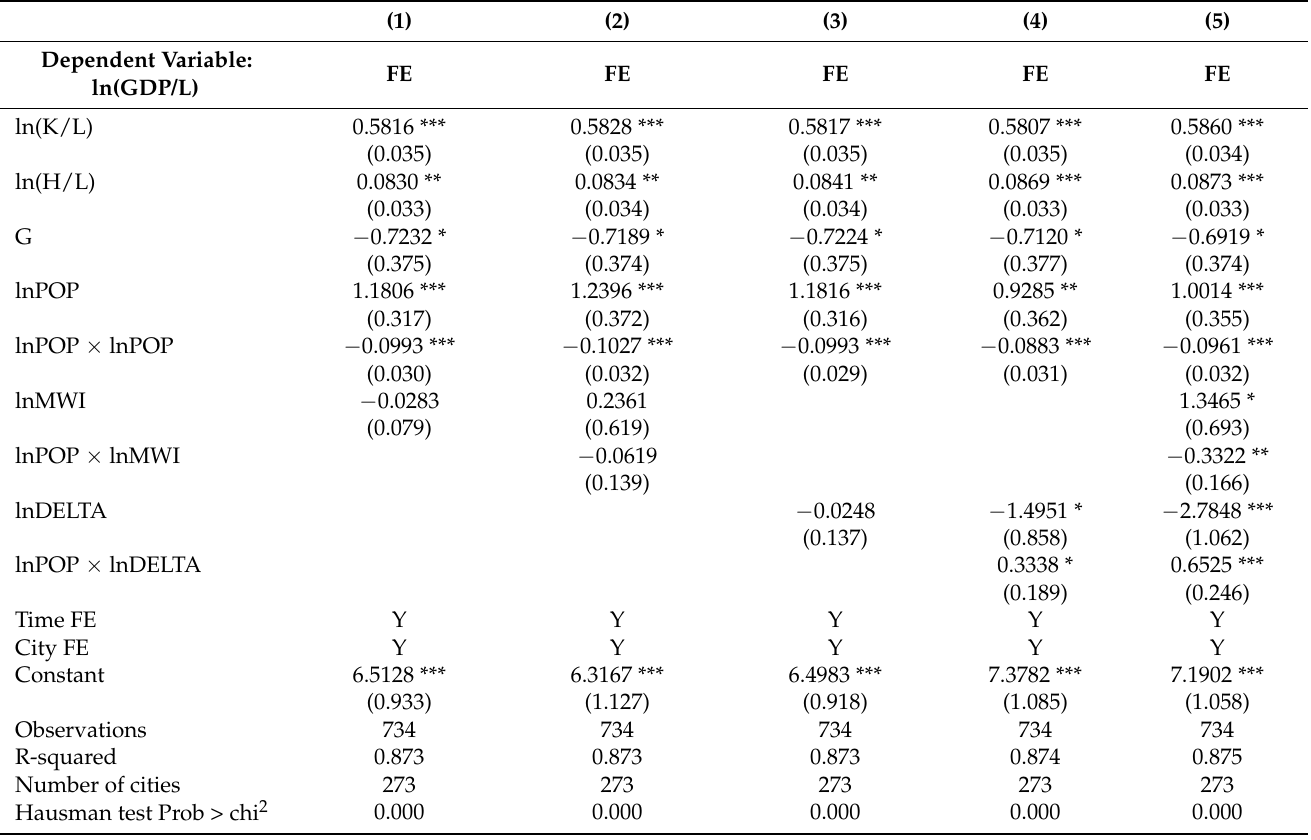
Table 3. OLS regressions with time and city fixed